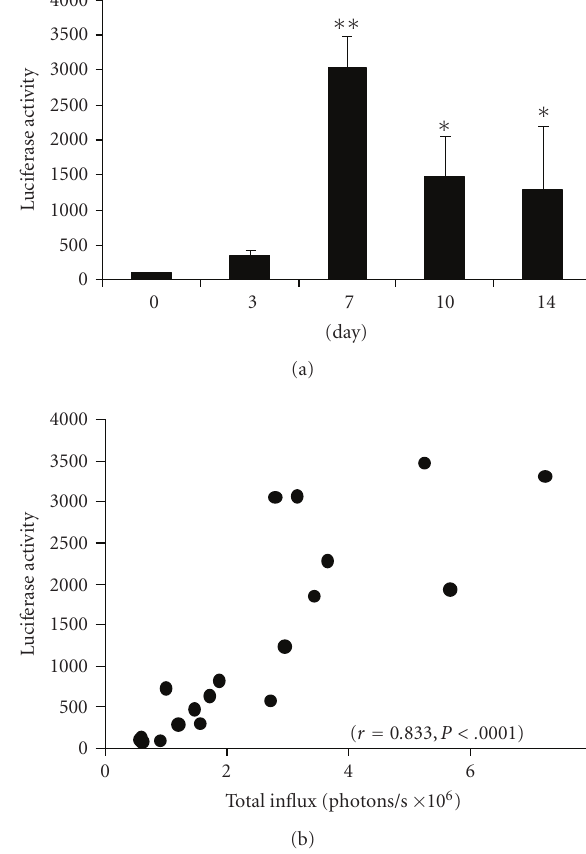
Figure 3: (a) Luciferase activity of calvarial tissues retrieved on the indicated days and then subjected to a luciferase assay ( n = 3-5 per bar, Mean ± SD, ∗ P < . 05, ∗∗ P < . 0001 versus value on day 0). (b) Correlation between total influx and luciferase activity of the calvariae ( n = 19, r = 0 . 833, P < .